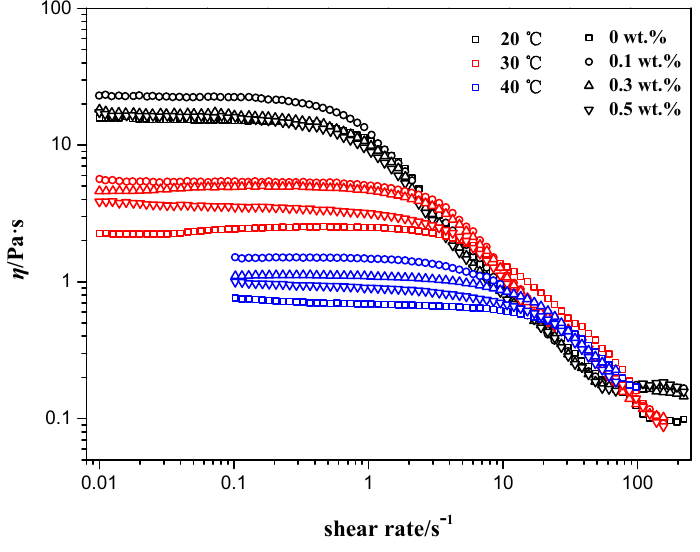
Figure 1. Steady shear viscosities of NEWMS with addition of different silica mass fraction at 20, 30, and 40 °C.